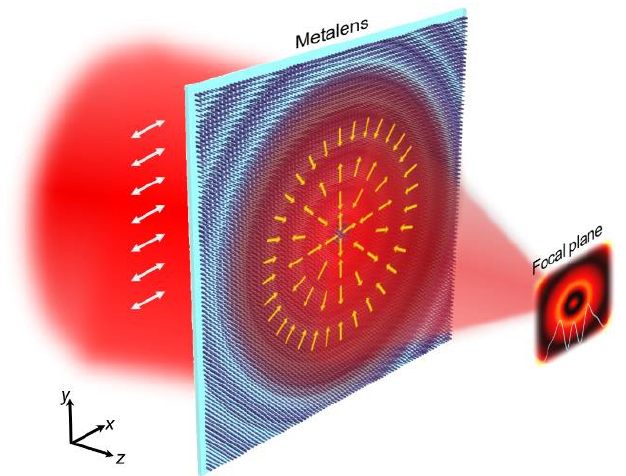
Figure 1. Schematic illustration of the superoscillatory focusing metalens. The arrows depict the instantaneous directions of electric component of the light field input and output from the metalens.